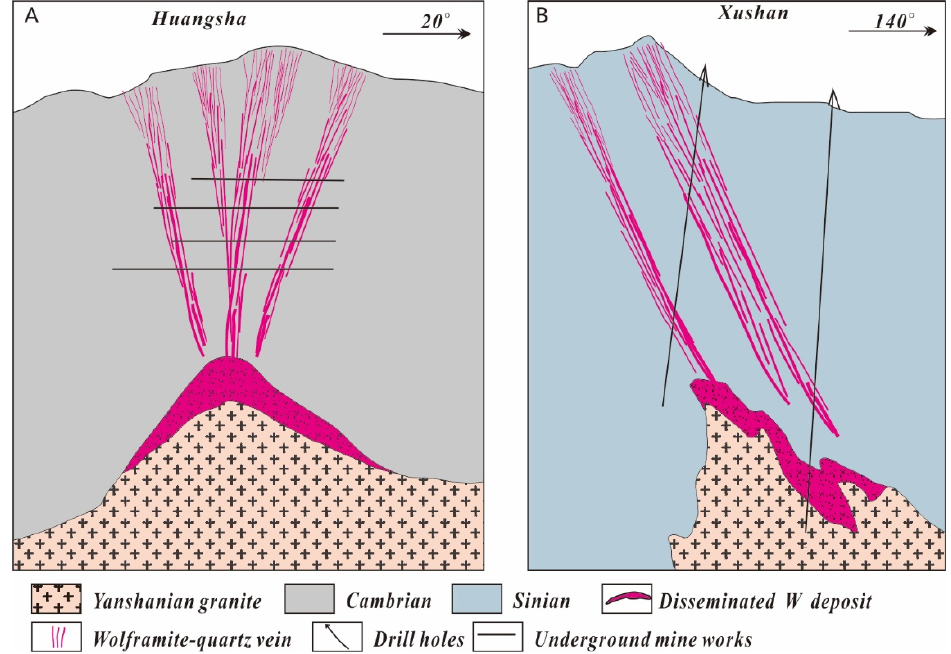
Figure 9. Cross sections of the Huangsha and ( A ) Xushan ( B ) tungsten deposits, both showing the spatial relationship between veins, greisen and granitic intrusions (modified after [23]).